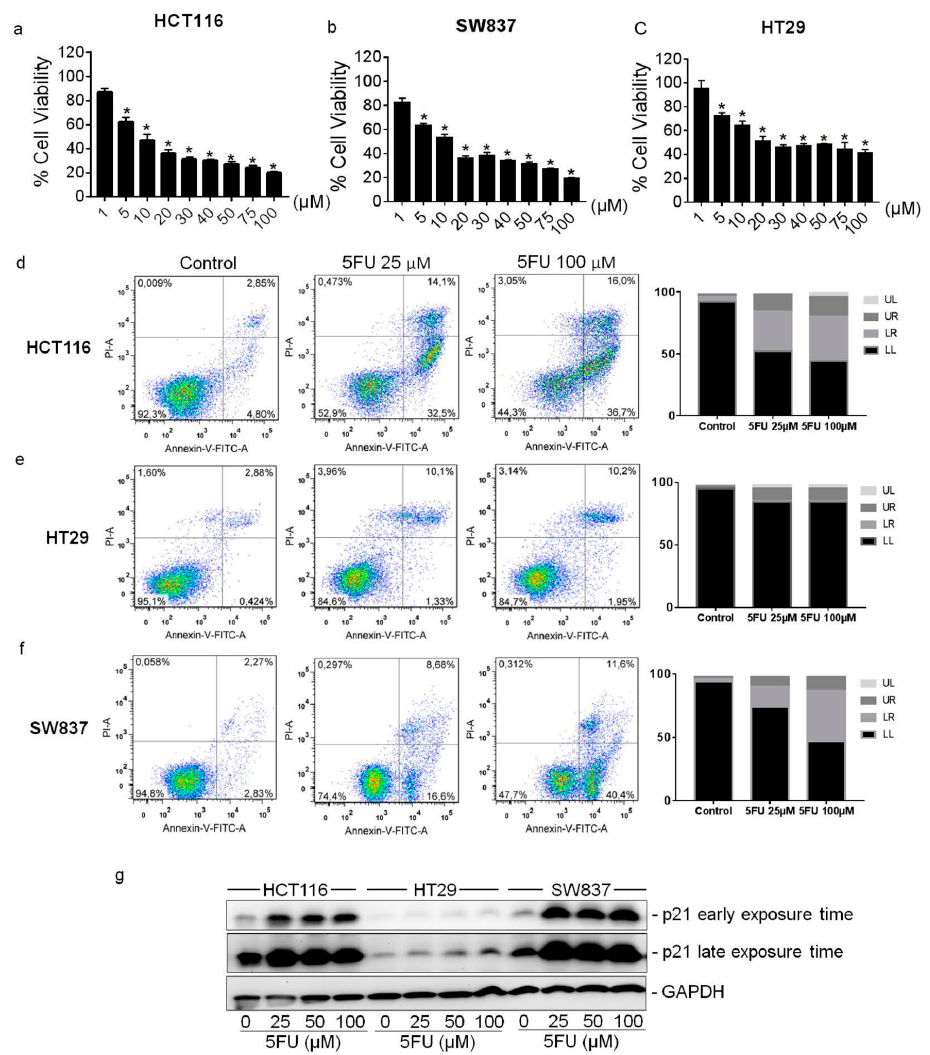
Figure 1. Susceptibility of colorectal cancer cell lines towards 5FU treatment and p21 expression in 5FU-resistant cells. Effects of 5FU on cell viability of ( a ) HCT116 ( b ) SW837 and ( c ) HT29 cells. Cells were treated with various concentrations of 5FU (0–100 µ M) for 48 h. The percentage of cell viability was determined by the MTT assay. Values represent means ± SD of three independent experiments. * p < 0.05 versus non-treated control. Effects of 5FU on cell apoptosis of ( d ) HCT116 ( e ) HT29 and ( f ) SW837 cells. Cells were treated with 25 µ M or 100 µ M of 5FU for 48 h.